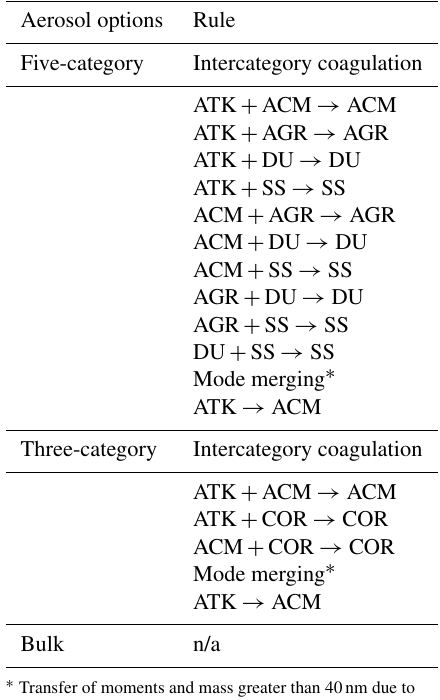
Table 2. Rules for the transfer of moments and chemical mass con- centrations from one category to another due to intercategory coag- ulation and mode